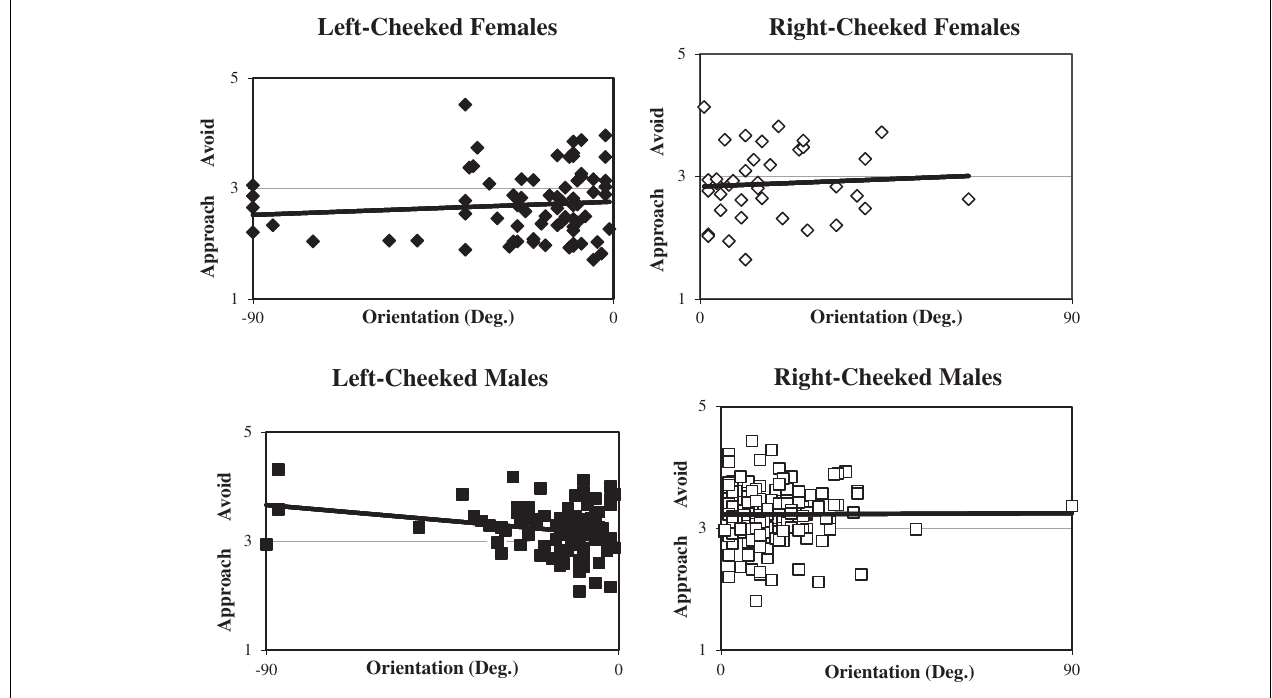
(closed diamonds) – shows left-cheeked females ( − 90° to − 1° orientation), lower right (open diamonds) – shows right-cheeked females ( + 1° to + 90° orientation). Linear regressions are plotted for each graph. Here 2 indicates a rating of “mildly approach,” 3 indicates “neutral,” and 4 indicates “mildly